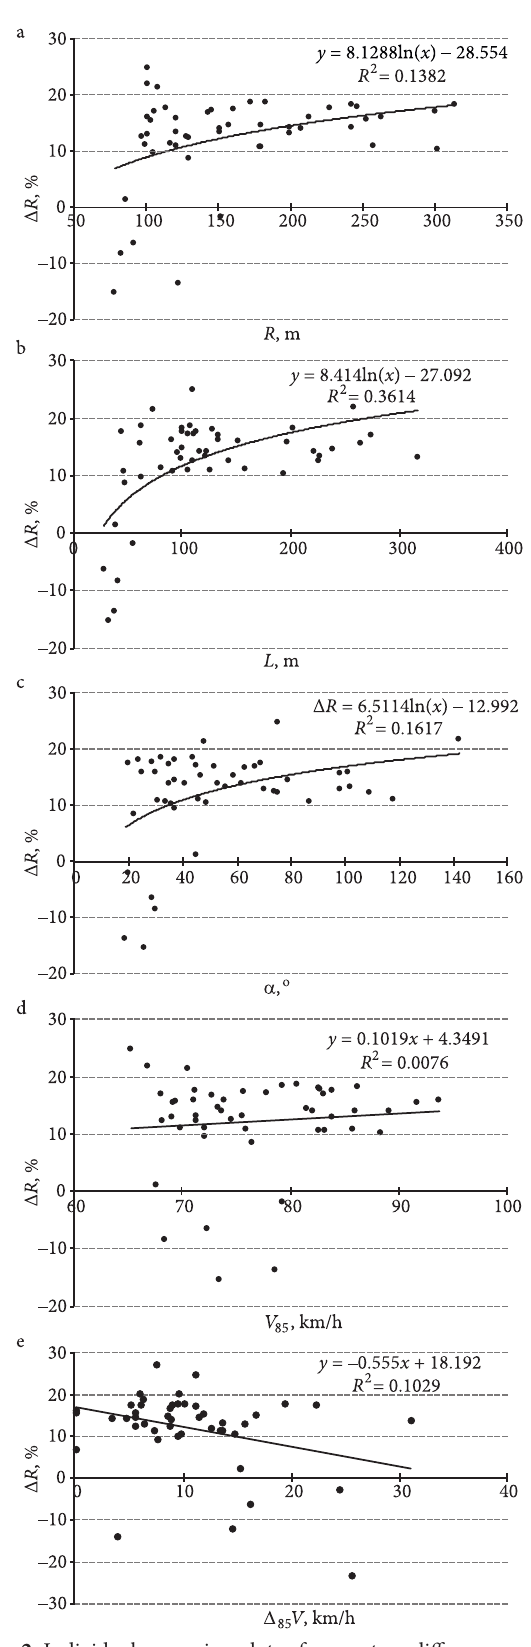
Fig. 2. Individual regression plots of percentage difference between radii versus: a – curve radius; b – curve length; c – deflection angle; d – operating speed; e – speed differential (for one